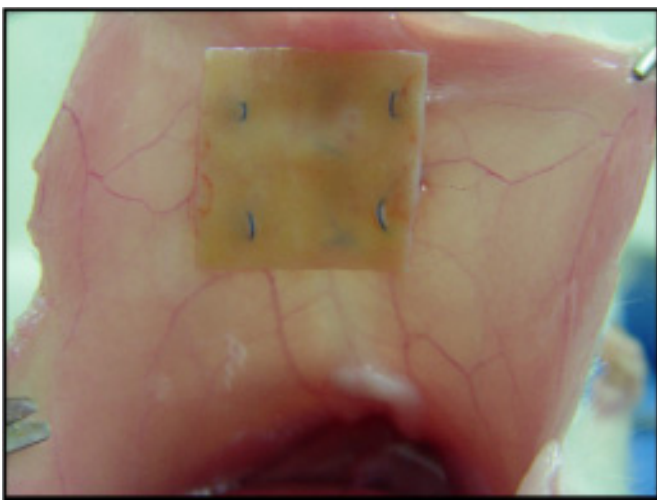
FIGURE 2 - Rat from group 2 with adhesions to the SIS mesh